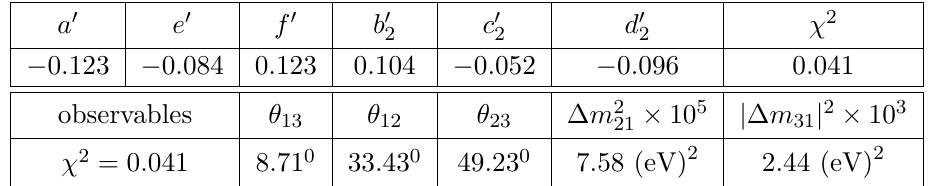
Table 7 . Parameters and observables corresponding (cid:31) 2 = 0 : 041 for inverted hierarchy. primed parameters is obtained (cf. table 7). Then similar to the previous case varying M in a wide range a lower and upper bound on M ( M ) = 5 : 40 (cid:2) 10 11 GeV is obtained for the observed range of Y 1 upper is shown in the right panel of (cid:12)gure